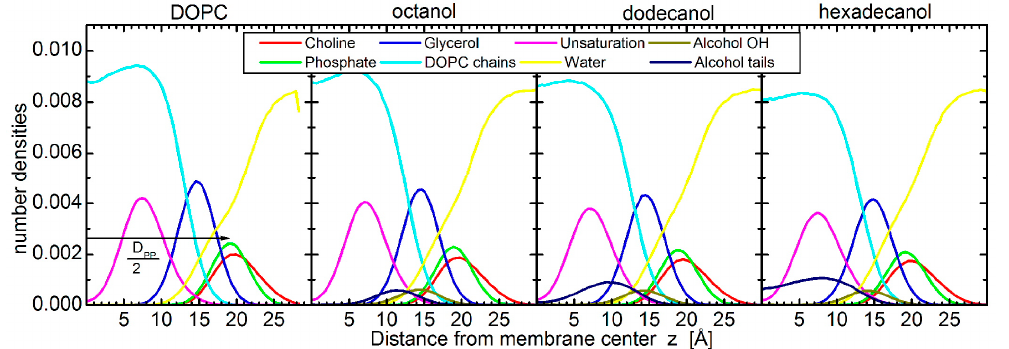
Figure 9. Number density distributions for different groups of DOPC (phosphates, glycerols, double bonds, acyl chains) and octanol, dodecanol, and hexadecanol (OH, alkyl tails), respectively from left to right. The determination of bilayer thickness as the phosphate-to-phosphate distance D PP is illustrated in the left-hand panel.